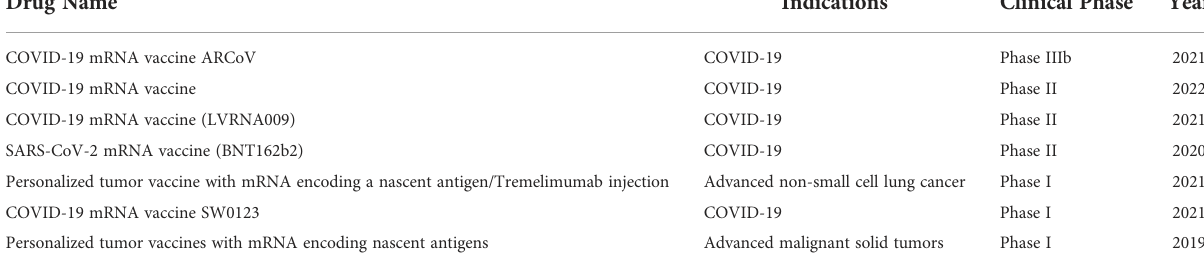
TABLE 2 Clinical pipeline of China mRNA drugs in